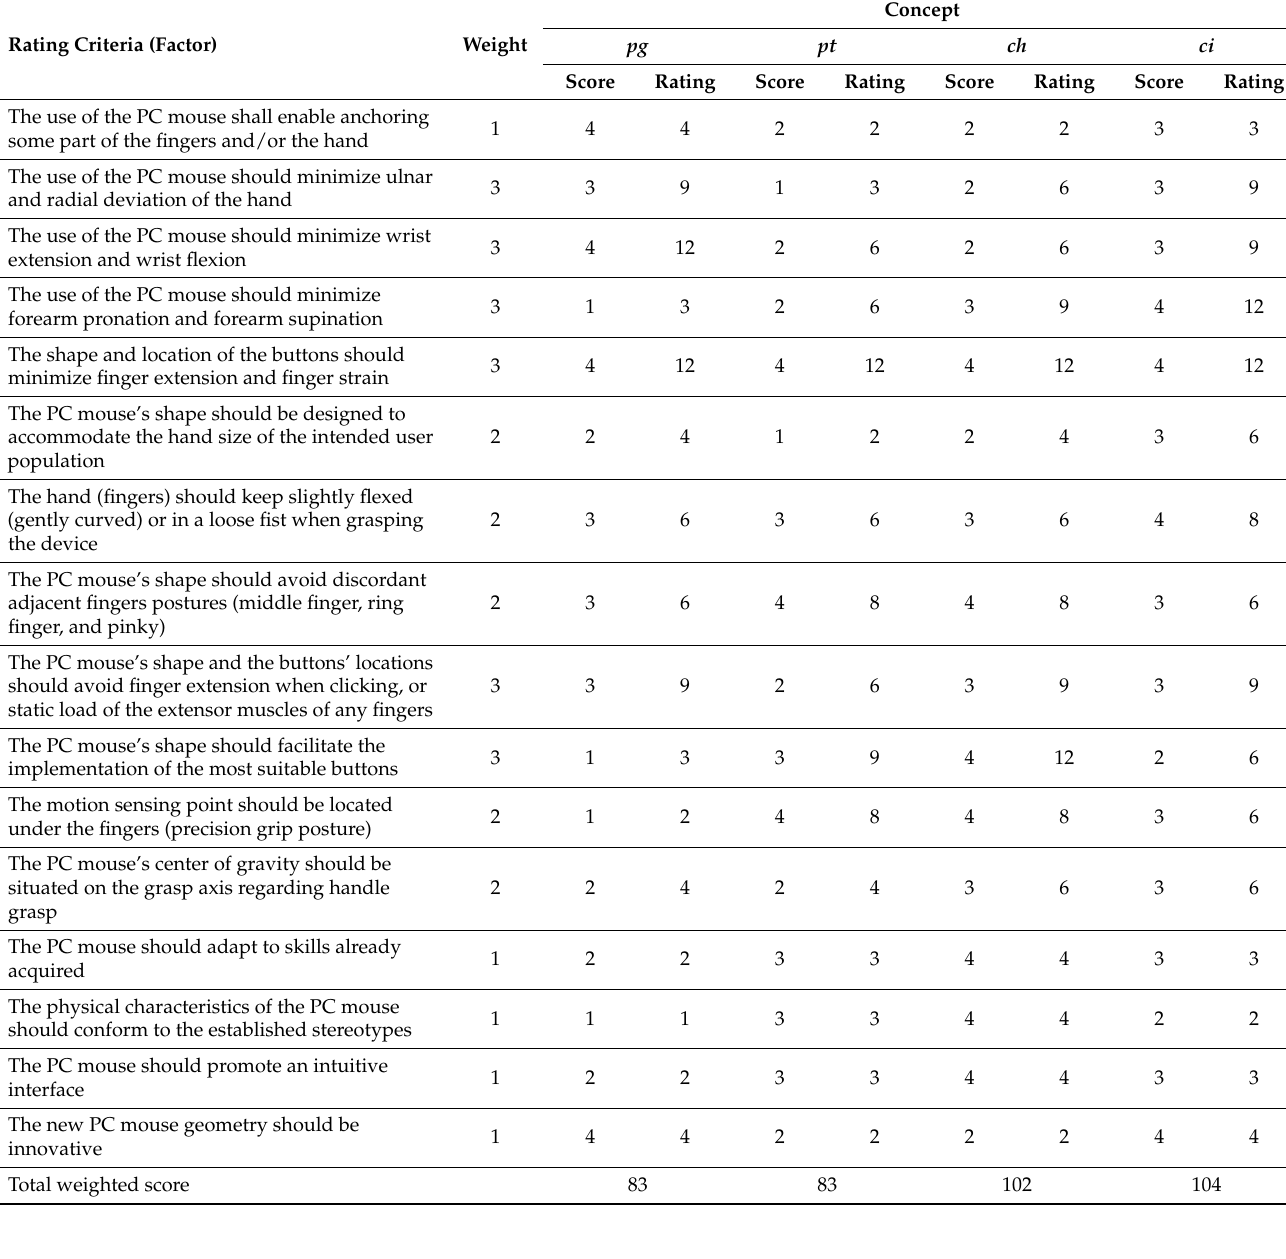
Table 2. Evaluation matrix (weights for each factor ranging from 1 (less important) to 3 (most important); the rating for each factor ranging from 1 (worse) to 4 (better)).